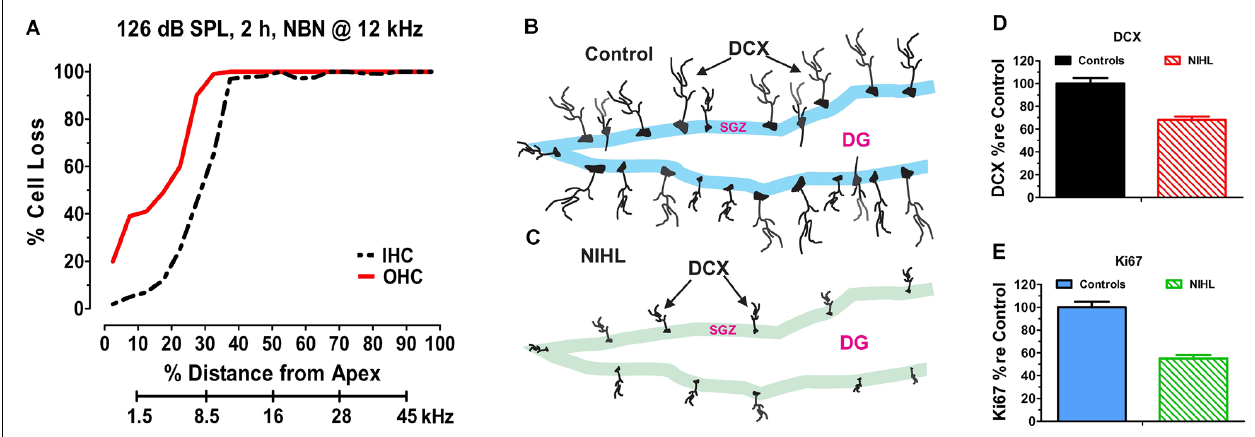
FIGURE 2 | Noise-induced hearing loss suppresses hippocampal cell proliferation and neurogenesis. (A) Cochleogram showing massive loss of outer hair cells (OHC) and inner hair cells (IHC) in the noise-exposed cochlear several months after a 2-h unilateral exposure to narrowband noise (NBN) centered at 12 kHz and presented at 126 dB SPL. Percent cell loss plotted as function of percent distance from the apex of the cochlear. Cochlear place related to frequency using rat tonotopic map on lower abscissa. (B) Schematic of dentate gyrus (DG) of hippocampus from normal control showing immunolabeled doublecortin (DCX) soma in the subgranular zone (SGZ); note extensive immunolabeled processes emanating from soma. (C) Schematic of DG of hippocampus several months after a noised induced hearing loss (NIHL) showing immunolabeled DCX) soma in the subgranular zone (SGZ). Note reduced number of DCX soma and paucity of labeled processes in the NIHL hippocampus compared to normal control (panel B ). (D) Schematic showing relative number (% re Control: percentage relative to control) of DCX labeled neurons in hippocampus of normal control rats (100%) and rats with noise-induced hearing loss (NIHL). (E) Schematic showing relative number (% re Control: percentage relative to control) of Ki67 labeled neurons in hippocampus of normal control rats (100%) and rats with noise-induced hearing loss